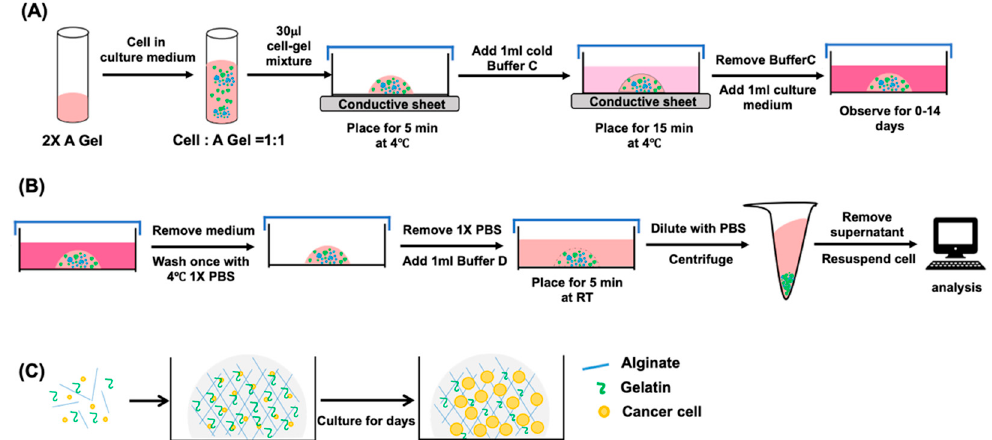
Figure 1. The procedures and principles underlying the ACD 3D culture system. ( A ) The process of gel formation. Cells suspended in culture medium are mixed with A gel, and 30 µ L of the cell–gel mixture were plated on a 24-well plate. After 5 min of reaction on ice and 15 min of reaction with C buffer to promote gel cross-linking, the gel becomes stable and flexible and can maintain and support cell growth for up to 14 days. ( B ) The process for dissolving the gel to collect spheroid cells. The culture medium is removed, and the gel is washed once with 1 × PBS. D buffer is added and incubated for 5 min to dissolve the gel. D buffer is diluted with 3 volumes of 1 × PBS, followed by centrifugation for 10 min. Finally, cells are resuspended in 1 × PBS for analysis. ( C ) The principle mechanism of the ACD 3D culture system. Alginate and gelatin are the main components of A gel. Alginate forms the scaffold, and gelatin provides a cell adhesion motif for cancer cells and is released into the culture medium over time.